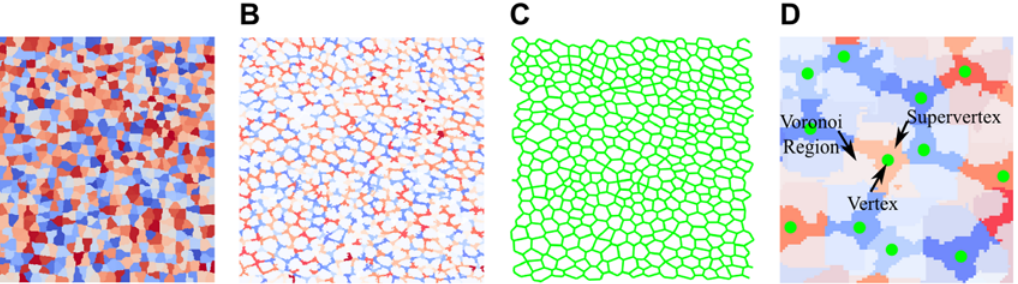
Fig 5. Establishing connectivity among AJ vertices to segment epithelial tissues. A) Voronoi regions are expanded from vertex locations to generate the Voronoi Diagram associating each voxel to the nearest AJ vertex. B) Supervertices are expanded inside Voronoi regions to link adjacent vertices. C) The AJs graph is built adding an edge between contiguous vertices through pairs of adjacent supervertices. D) Vertices, Voronoi regions and supervertices are